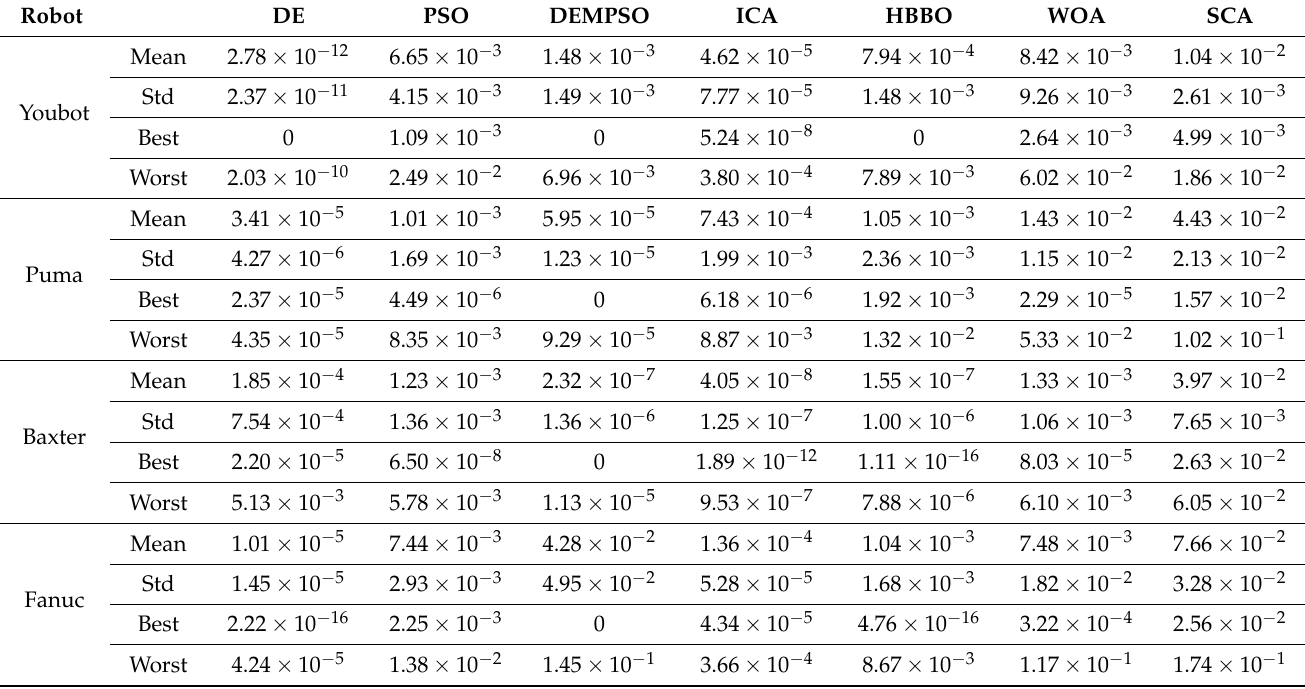
Table 8. Position error results for the lemniscate path.